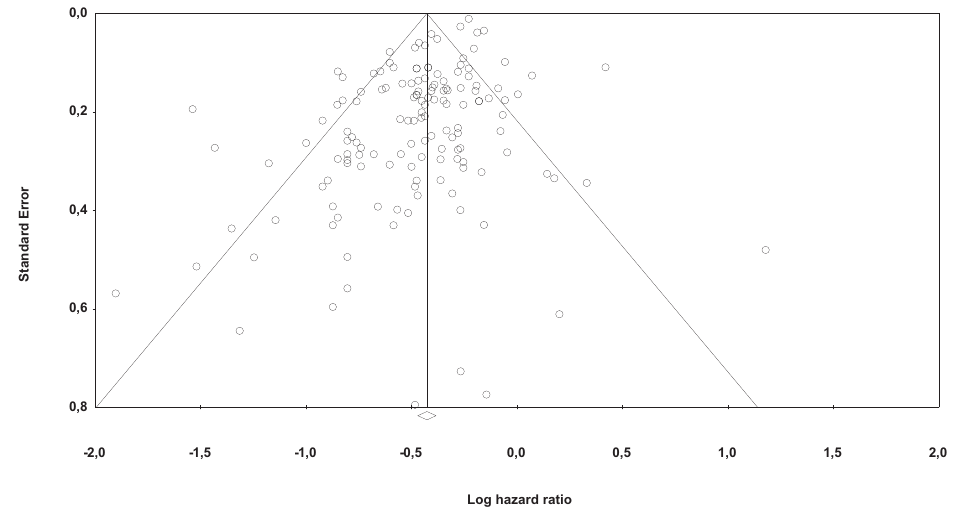
Figure 4. Funnel plot of publication bias for overall survival analysis showing standard error by log hazard